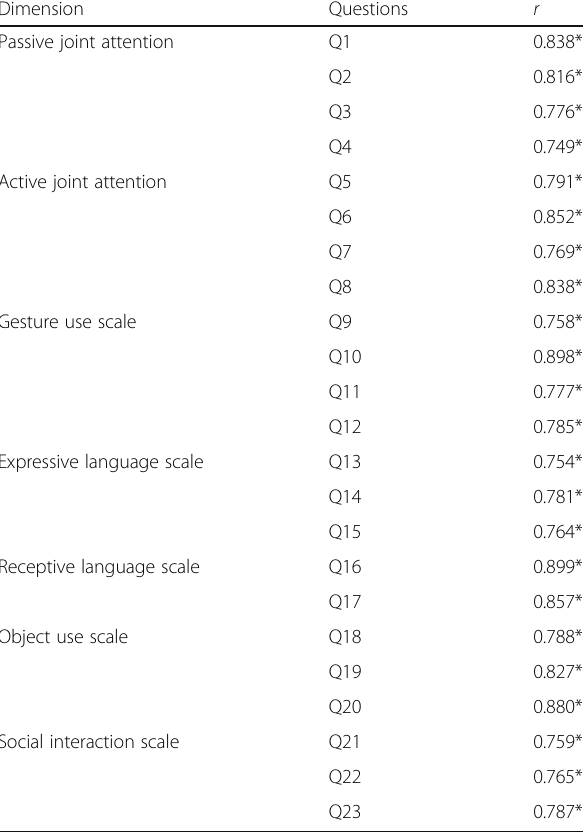
Table 4 The internal consistency of the seven scales of